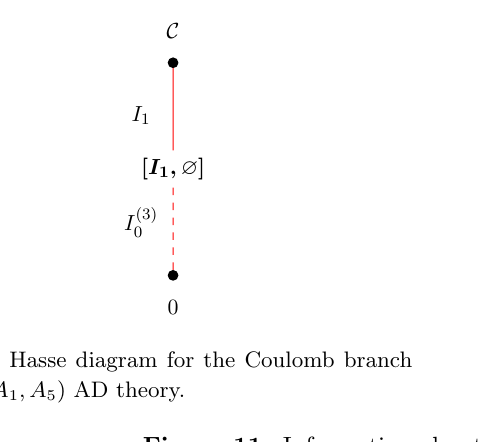
Figure 11. Information about the ( A 1 ; A 5 ) AD